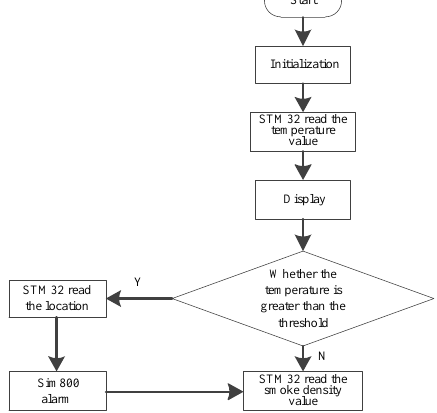
Fig. 9 . The software flow chart of the temperature monitoring module.